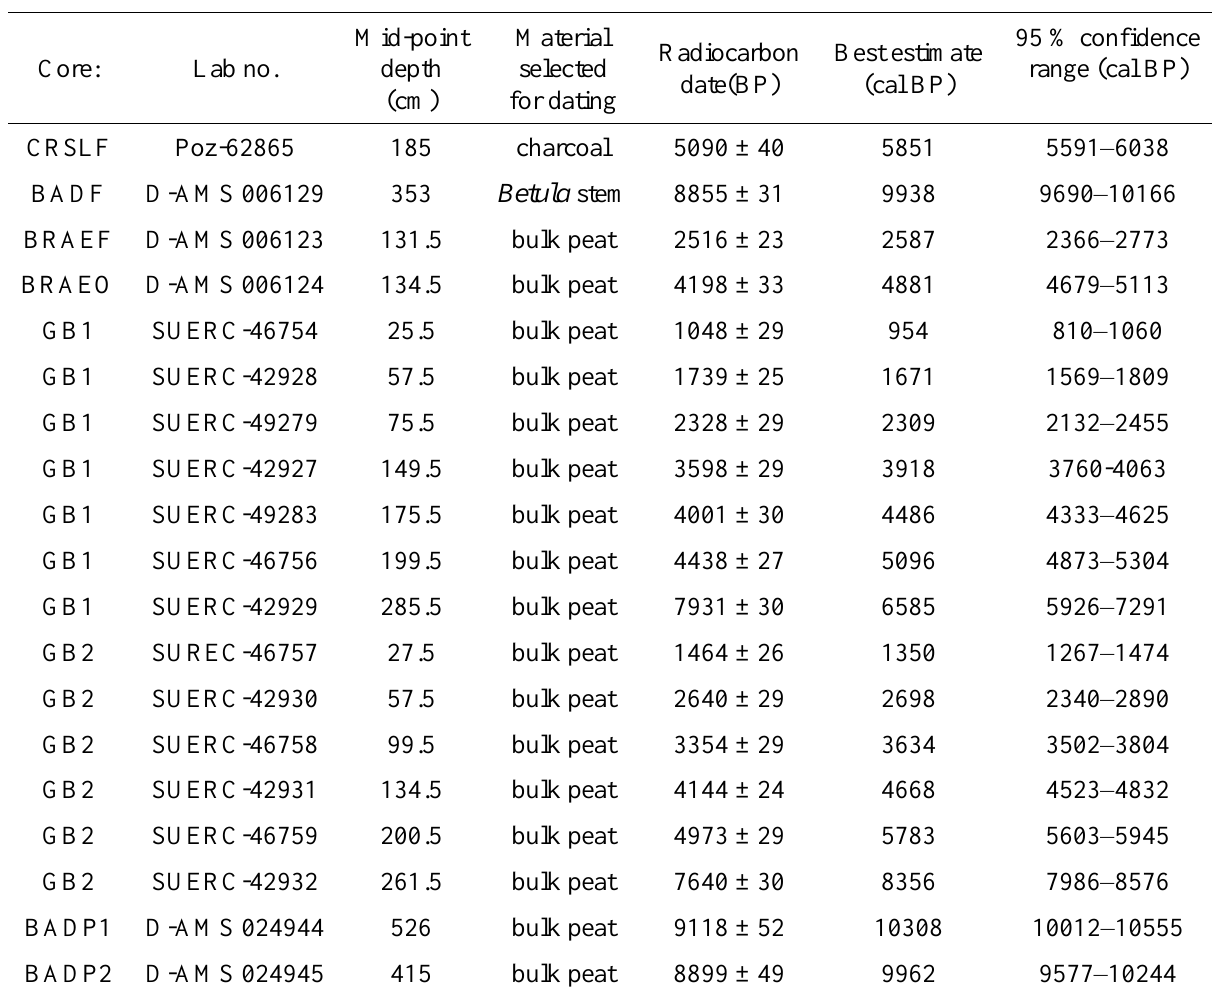
Table 1. Full details of radiocarbon dates for cores not previously published. Calibrated ages were derived from the BACON age-depth models with the INTCAL13 calibration curve. Best estimate of the calibrated date is presented as the weighted mean following the recommendation of Telford et al .